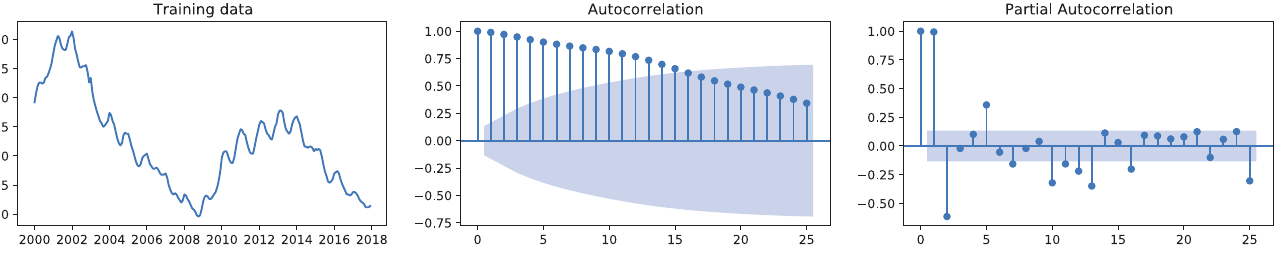
Figure 2. Training data, ACF and PACF plots for